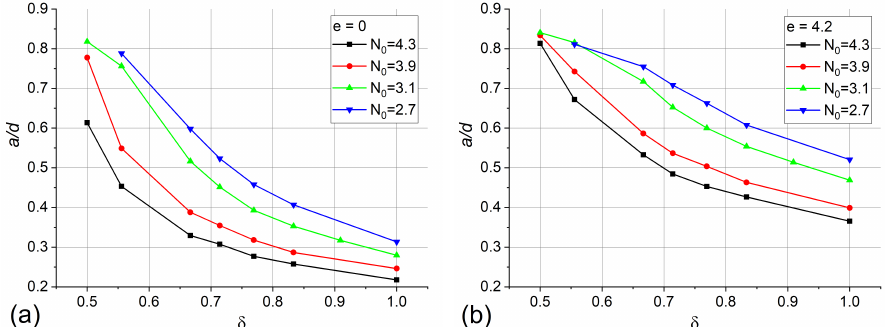
Figure 4. Calculated dependencies of a / d ratio on droplet compression ratio δ at no electric field ( a ) and at e = 4.2 ( b ).